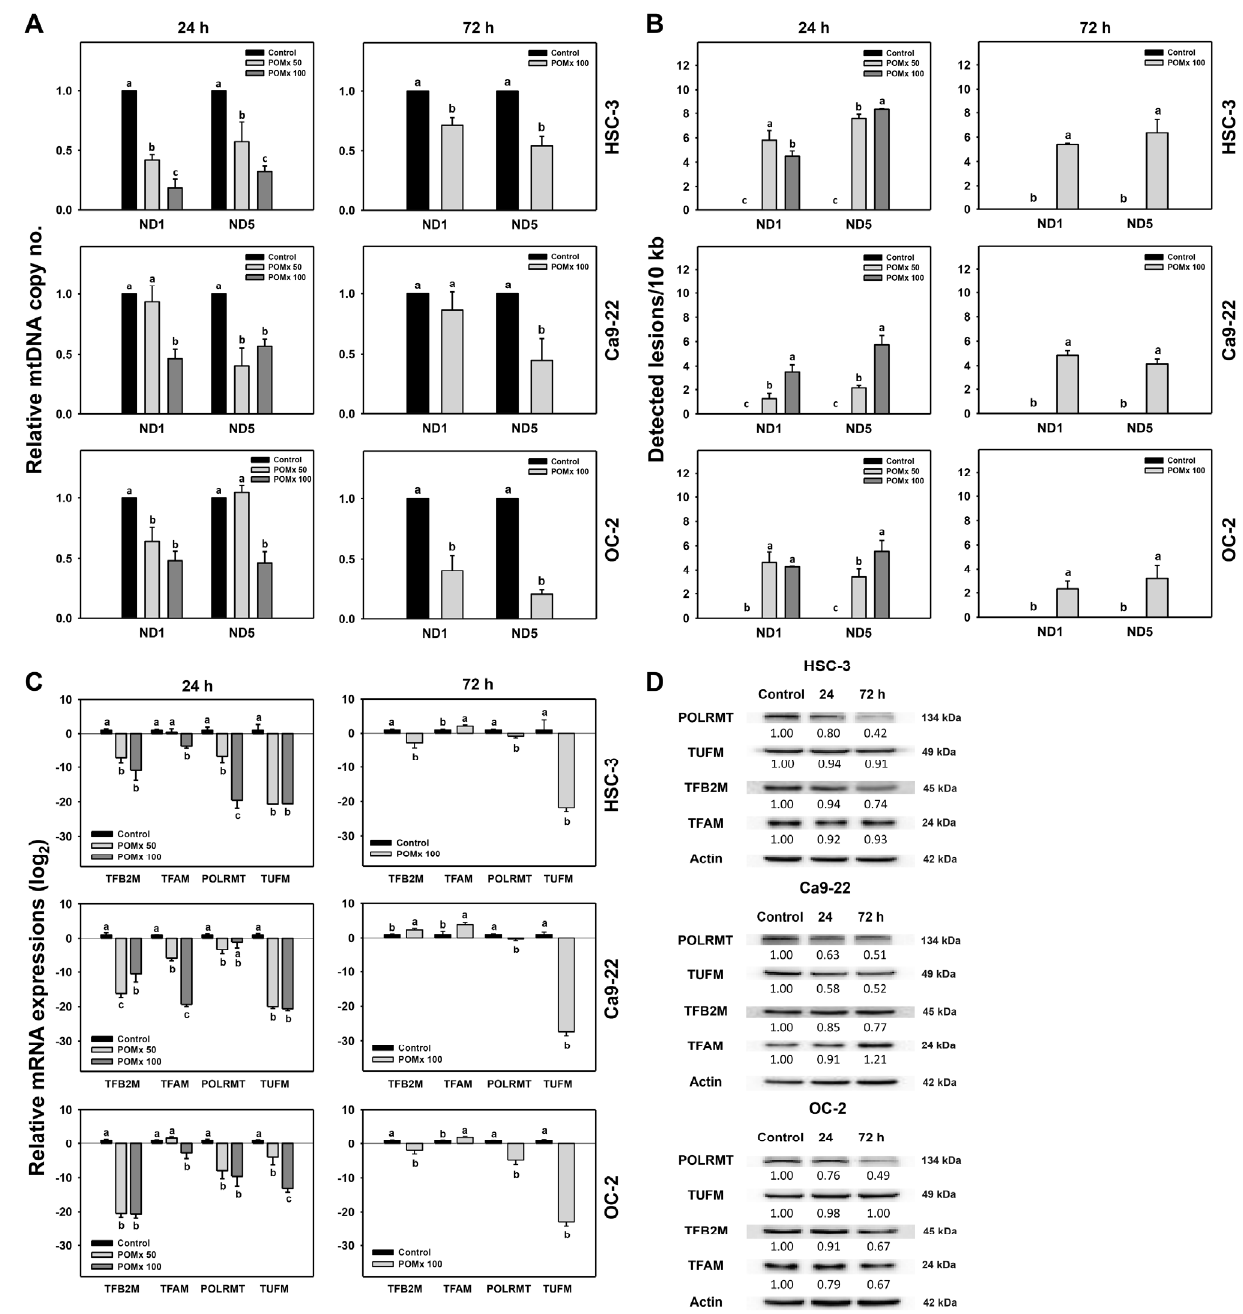
Figure 9. mtDNA copy number, mtDNA lesion, and mitochondrial biogenesis of oral cancer cells after POMx incubation. Cells (HSC-3, Ca9-22, and OC-2) were incubated with 0, 50, and 100 µ g/mL of POMx (control, POMx 50, and POMx 100) for 24 and 72 h. ( A ) Relative mtDNA copy number in ND1 and ND5 genes. ( B ) mtDNA lesion frequency per 10 kb DNA between ND1 to ND5 genes. ( C ) Relative mRNA expressions (log 2 ) for mitochondrial biogenesis genes. Treatments without overlapping low cases (a to c) are significantly different for the same cell lines. p < 0.05. Data, mean ± SD ( n = 3). ( D ) Western blotting for mitochondrial biogenesis genes at 24 and 72 h POMx incubations. Cells were incubated with control and 100 µ g/mL of POMx for 24 and 72